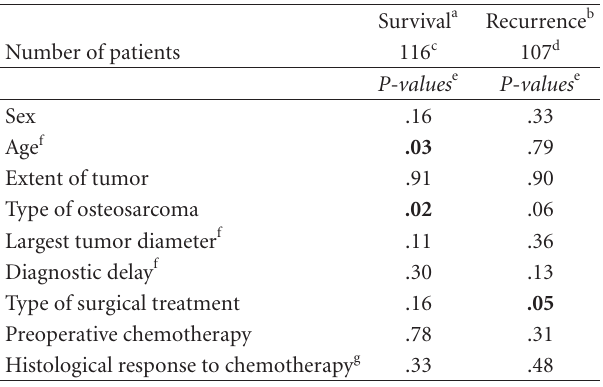
Table 7: Analyses of prognostic impact of clinicopathological, categorical variables, grouped as shown in Table